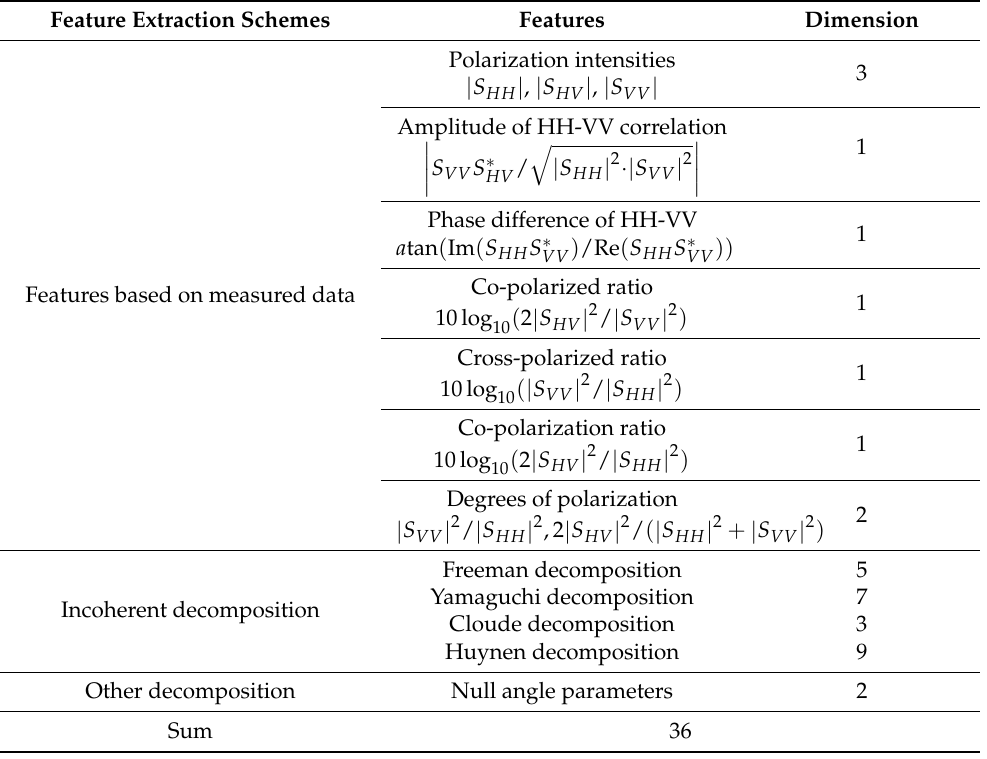
Table 1. The 36-dimensional decomposition features of single-temporal PolSAR